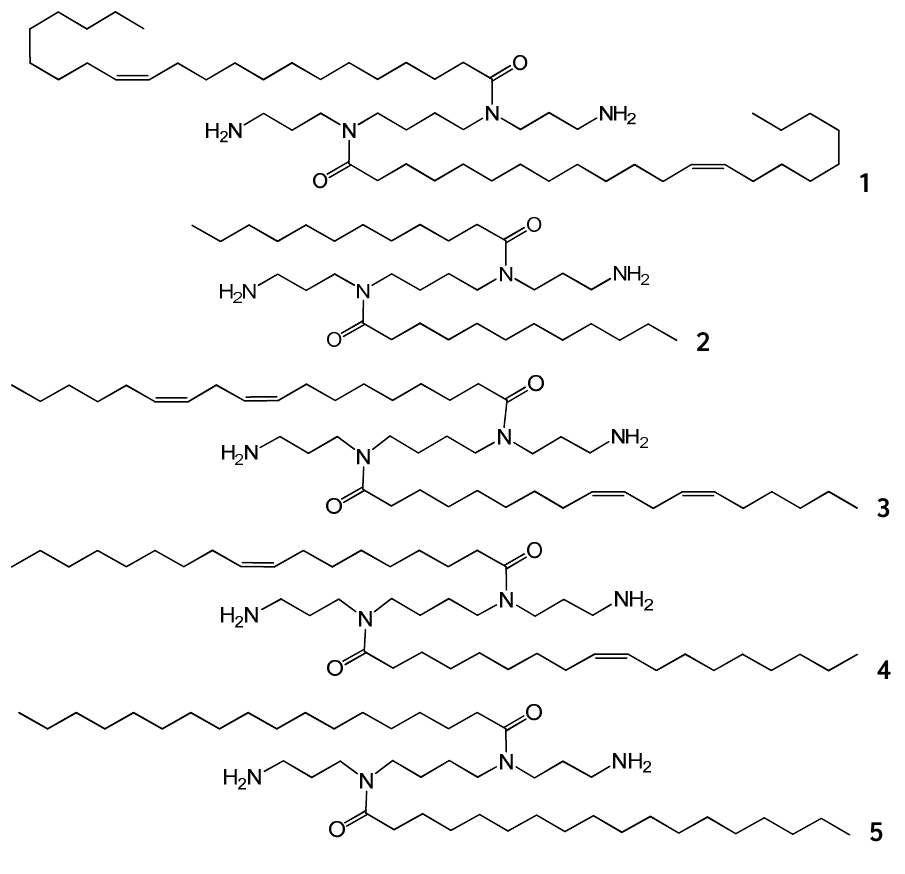
Figure 1. N 4 , N 9 -Difatty acid amides of